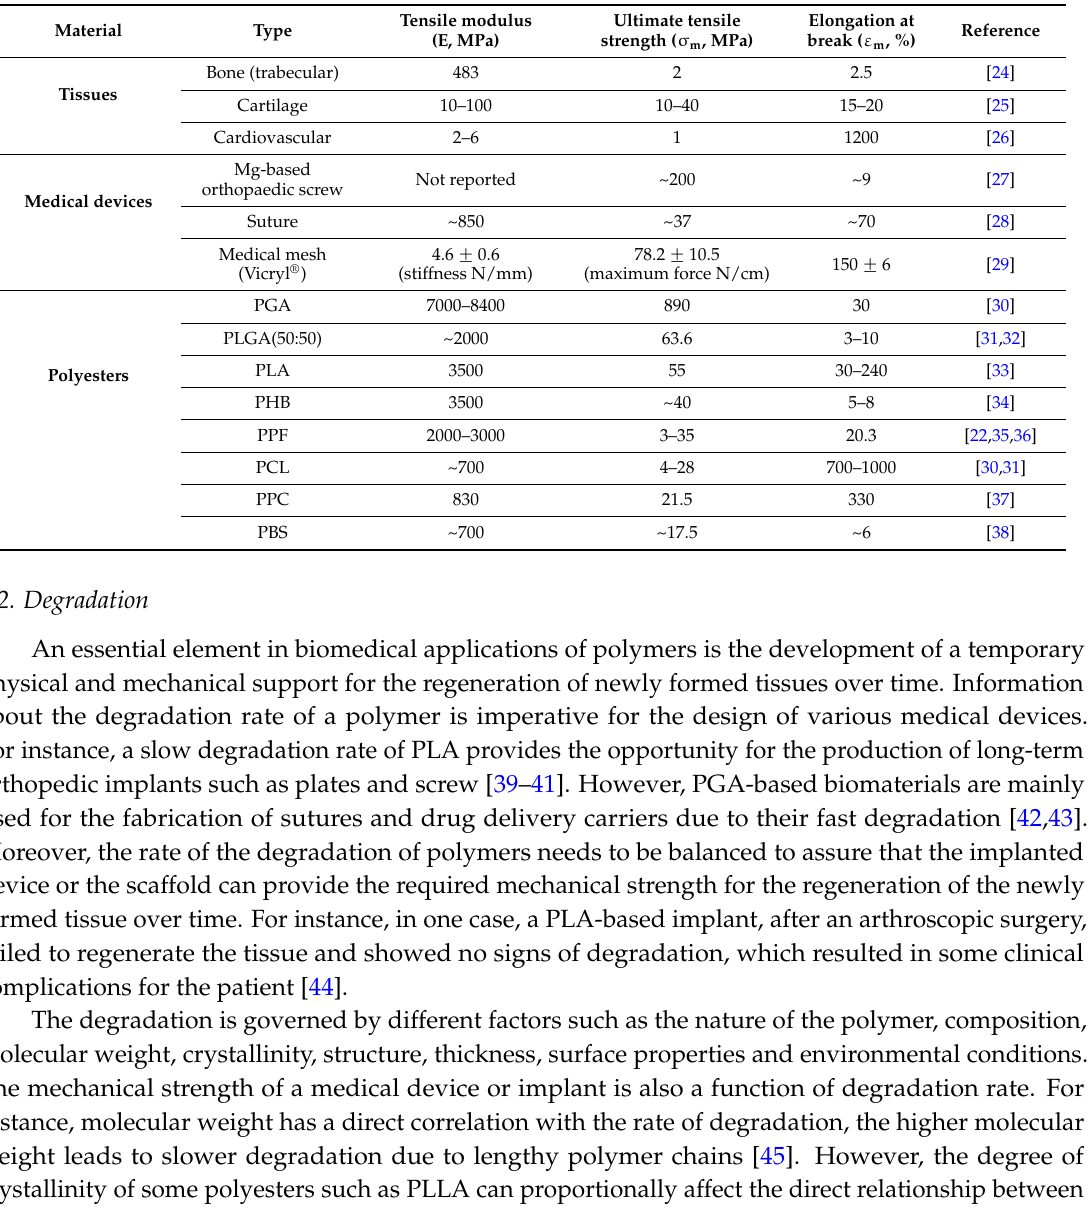
Table 1. Mechanical properties of the biodegradable polyesters and a few tissues and commercially available